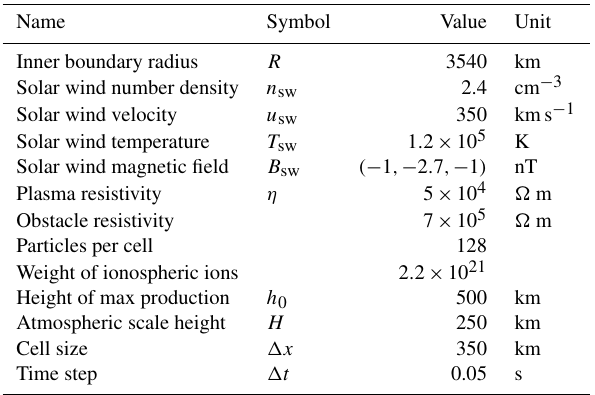
Table 1. The parameters used for all simulation runs.